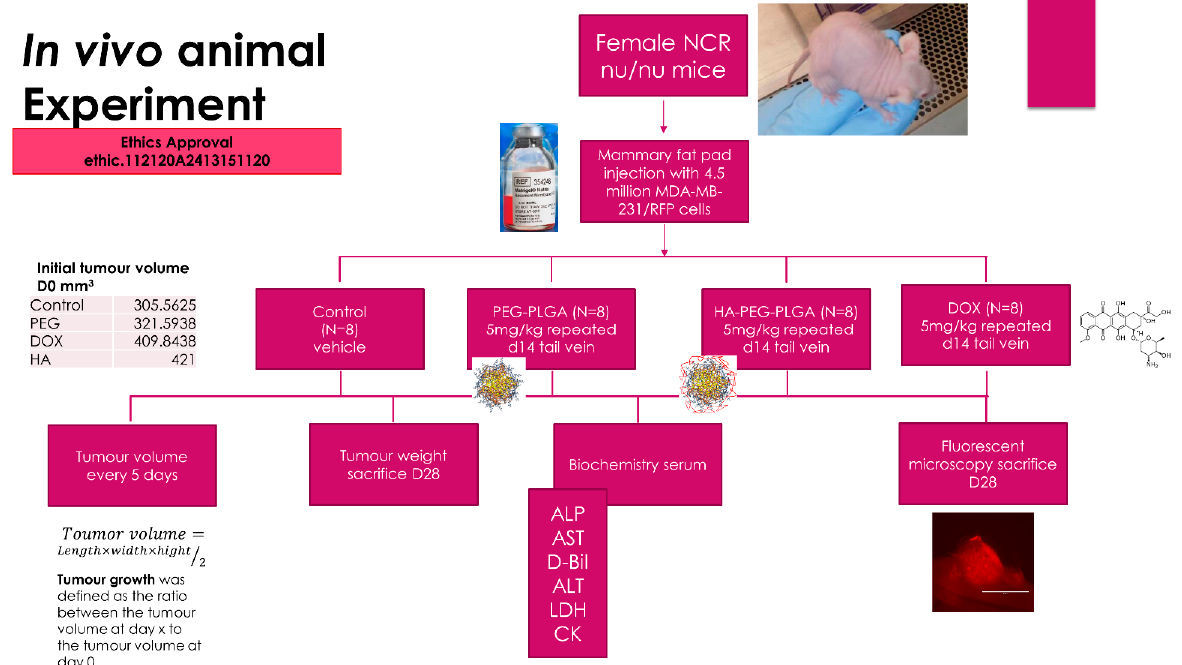
Figure 1. Experimental design of the in vivo experiment (DOX: free doxorubicin, PEG-PLGA: Doxorubicin loaded PEG-PLGA nanoparticles, HA-PEG-PLGA: Hyaluronic acid coated Doxorubicin loaded PEG-PLGA nanoparticles).